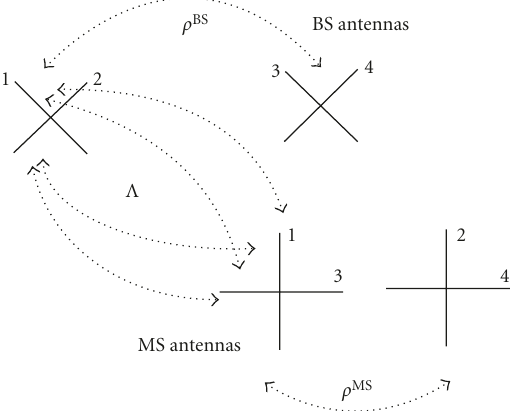
Figure 8: 3GPP LTE Kronecker approximation for the